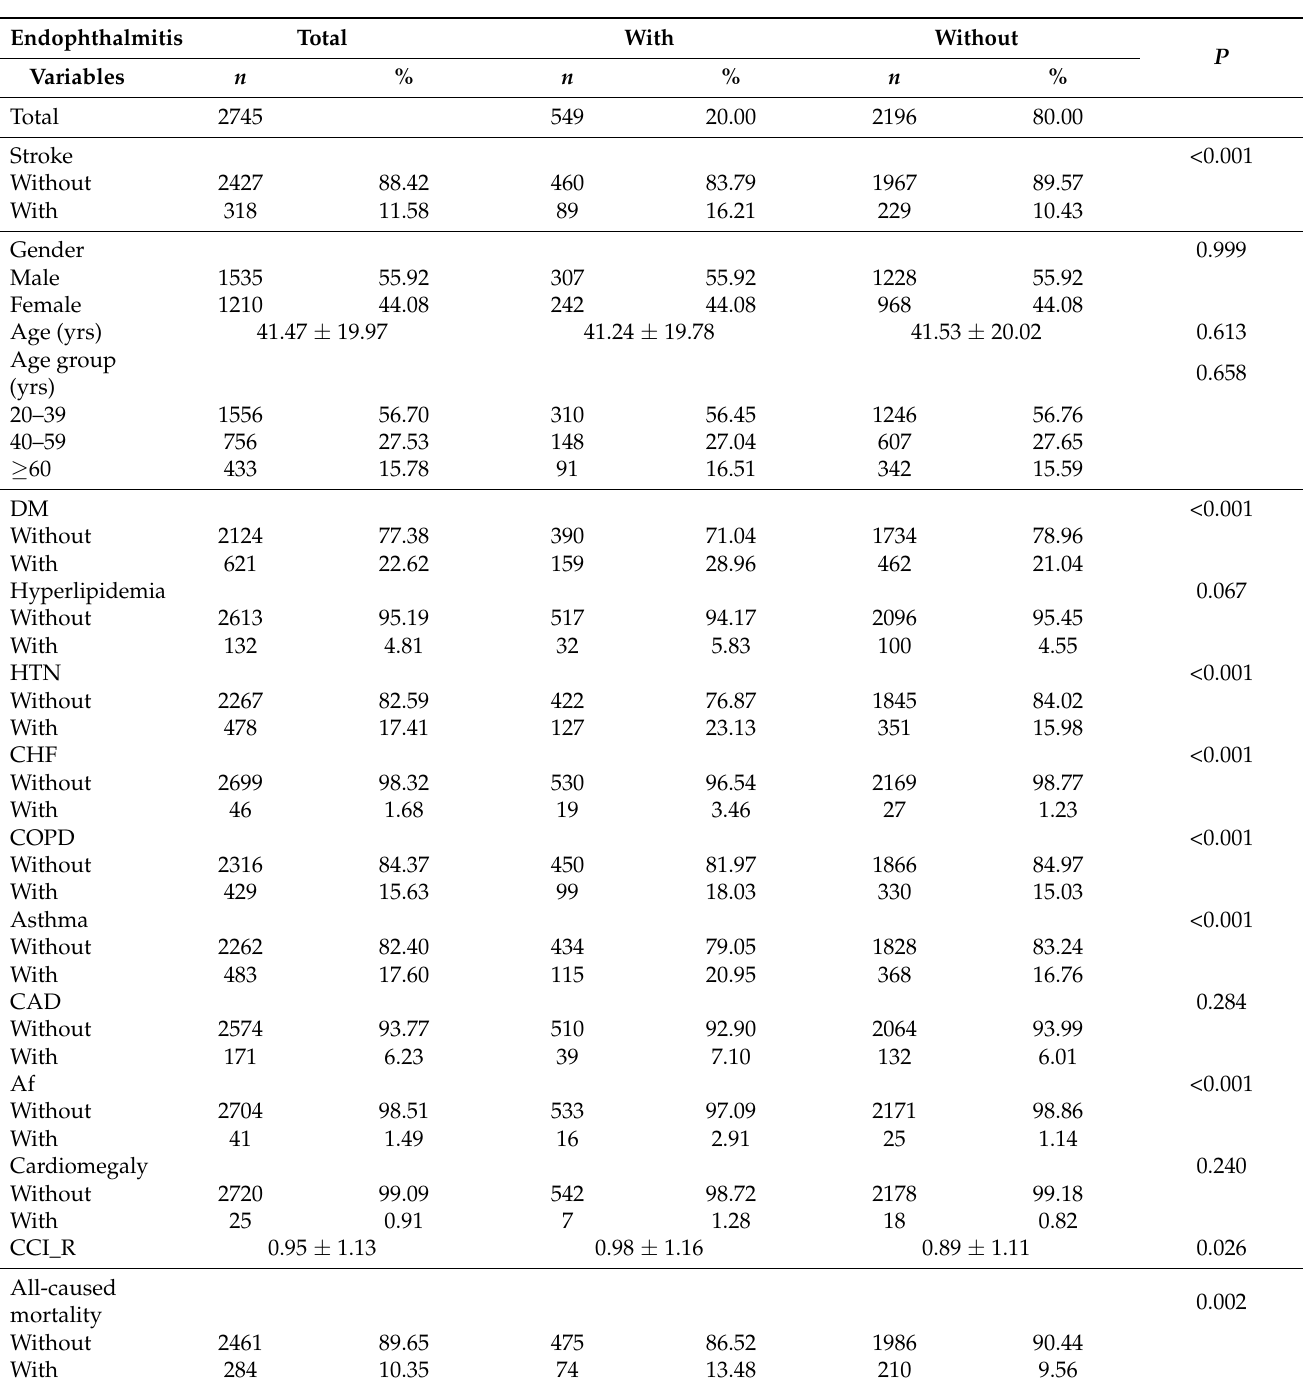
Table 2. Patient characteristics at study